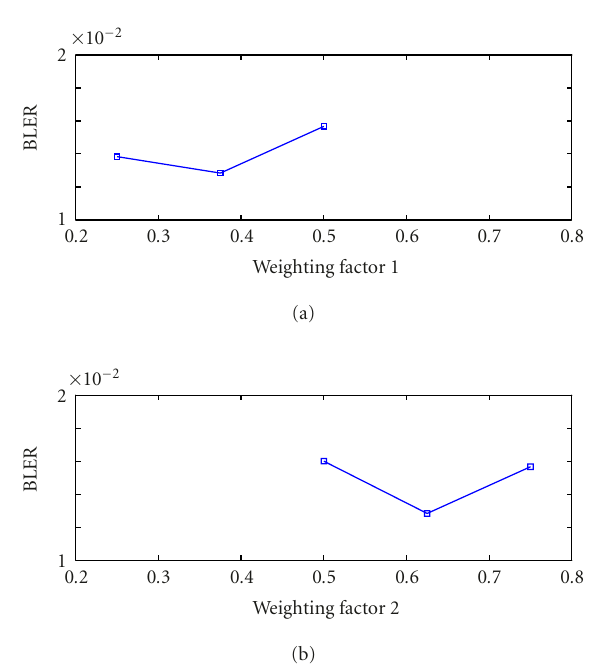
Figure 3: Two slices of the 2D search for optimal weighting factors are presented. (a) shows the block error rate (BLER) as function of weighting factor 1 when weighting factor 2 is set to 0.625. (b) shows the BLER as a function of weighting factor 2 when weighting factor 1 is set to 0 .